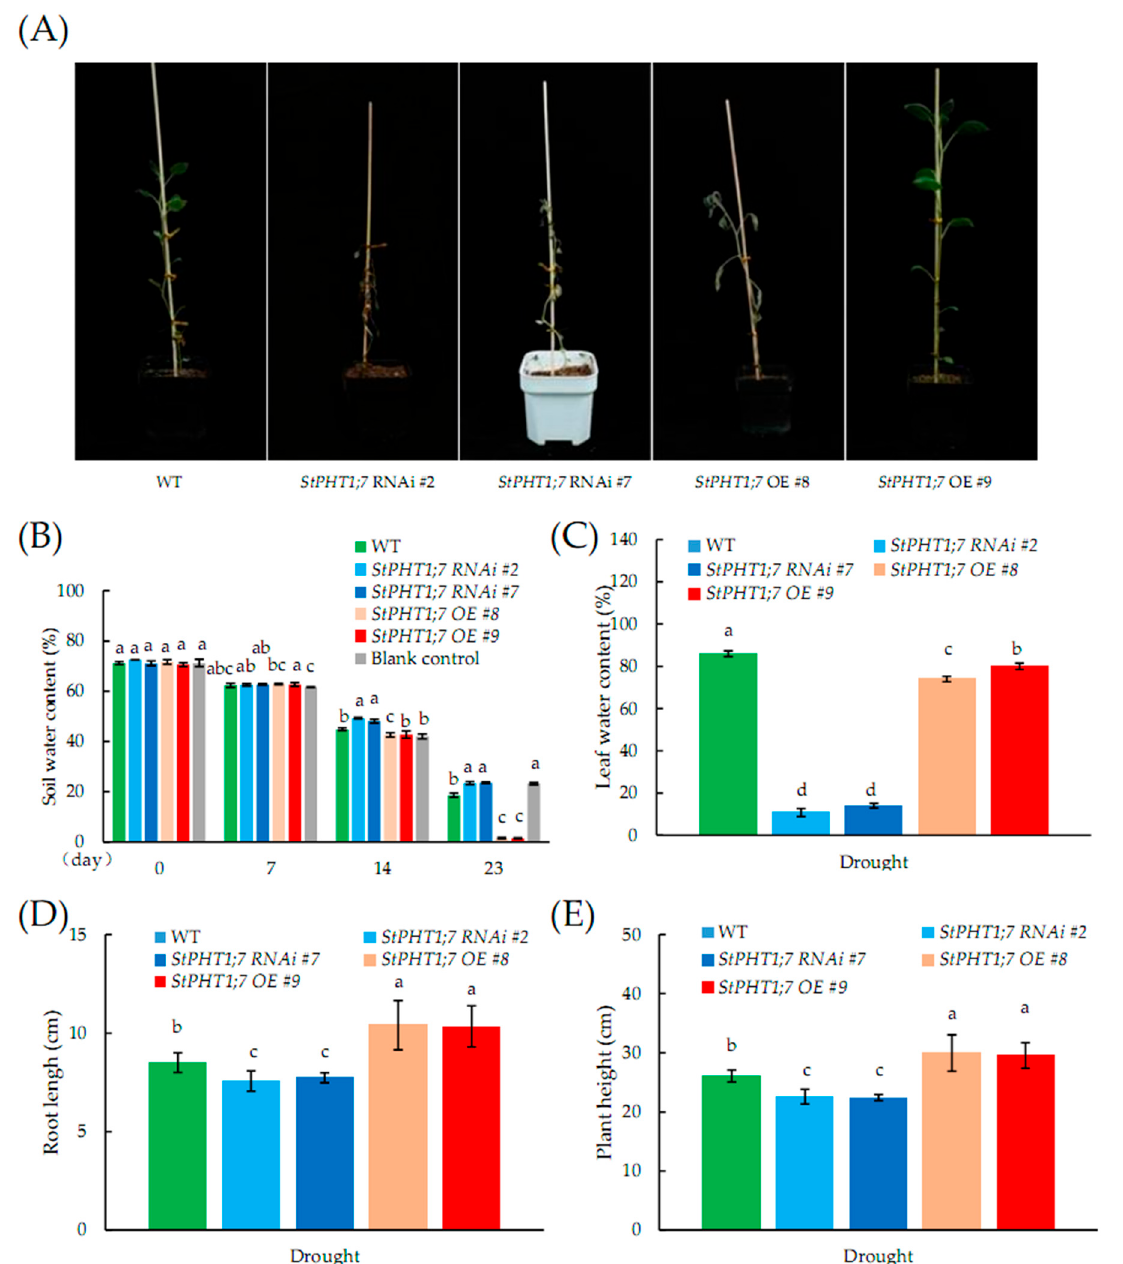
Figure 11. ( A ) Growth phenotype of different transgenic potato plants after 23 days of natural drought; ( B ) soil water content during the trial; ( C ) leaf water content of different transgenic potato lines after 23 days of drought treatment; ( D ) the root length of different transgenic potato lines after 23 days of drought treatment; ( E ) the plant height of different transgenic potato lines after 23 days of drought treatment. Each value is expressed as mean ± SD ( n = 9,3 biological repeats × 3 technical repeats). Different lowercase letters in the same column represent significant differences ( p ≤ 0.05) using Duncan’s multiple range test, respectively.